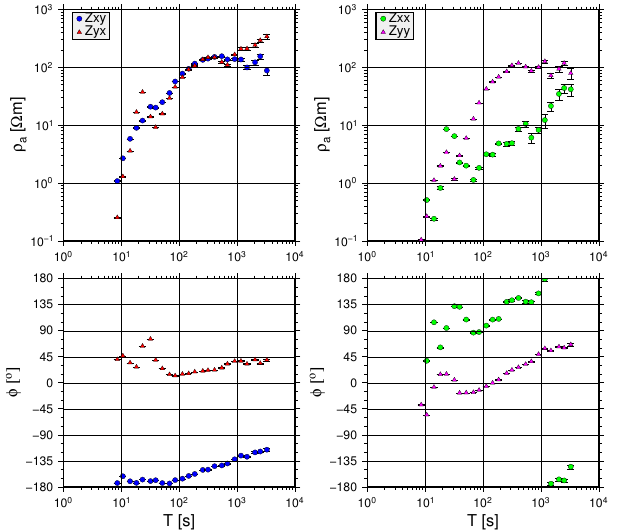
Figure 7. Sounding curves from the quasi-magnetotelluric transfer function between electric components of GRB and horizontal mag- netic ones of SUW. Data are the same as in Fig. 2. Note the simi- larity to the inter-station transfer function (Fig. 2a) in the “erratic” short-period behavior.